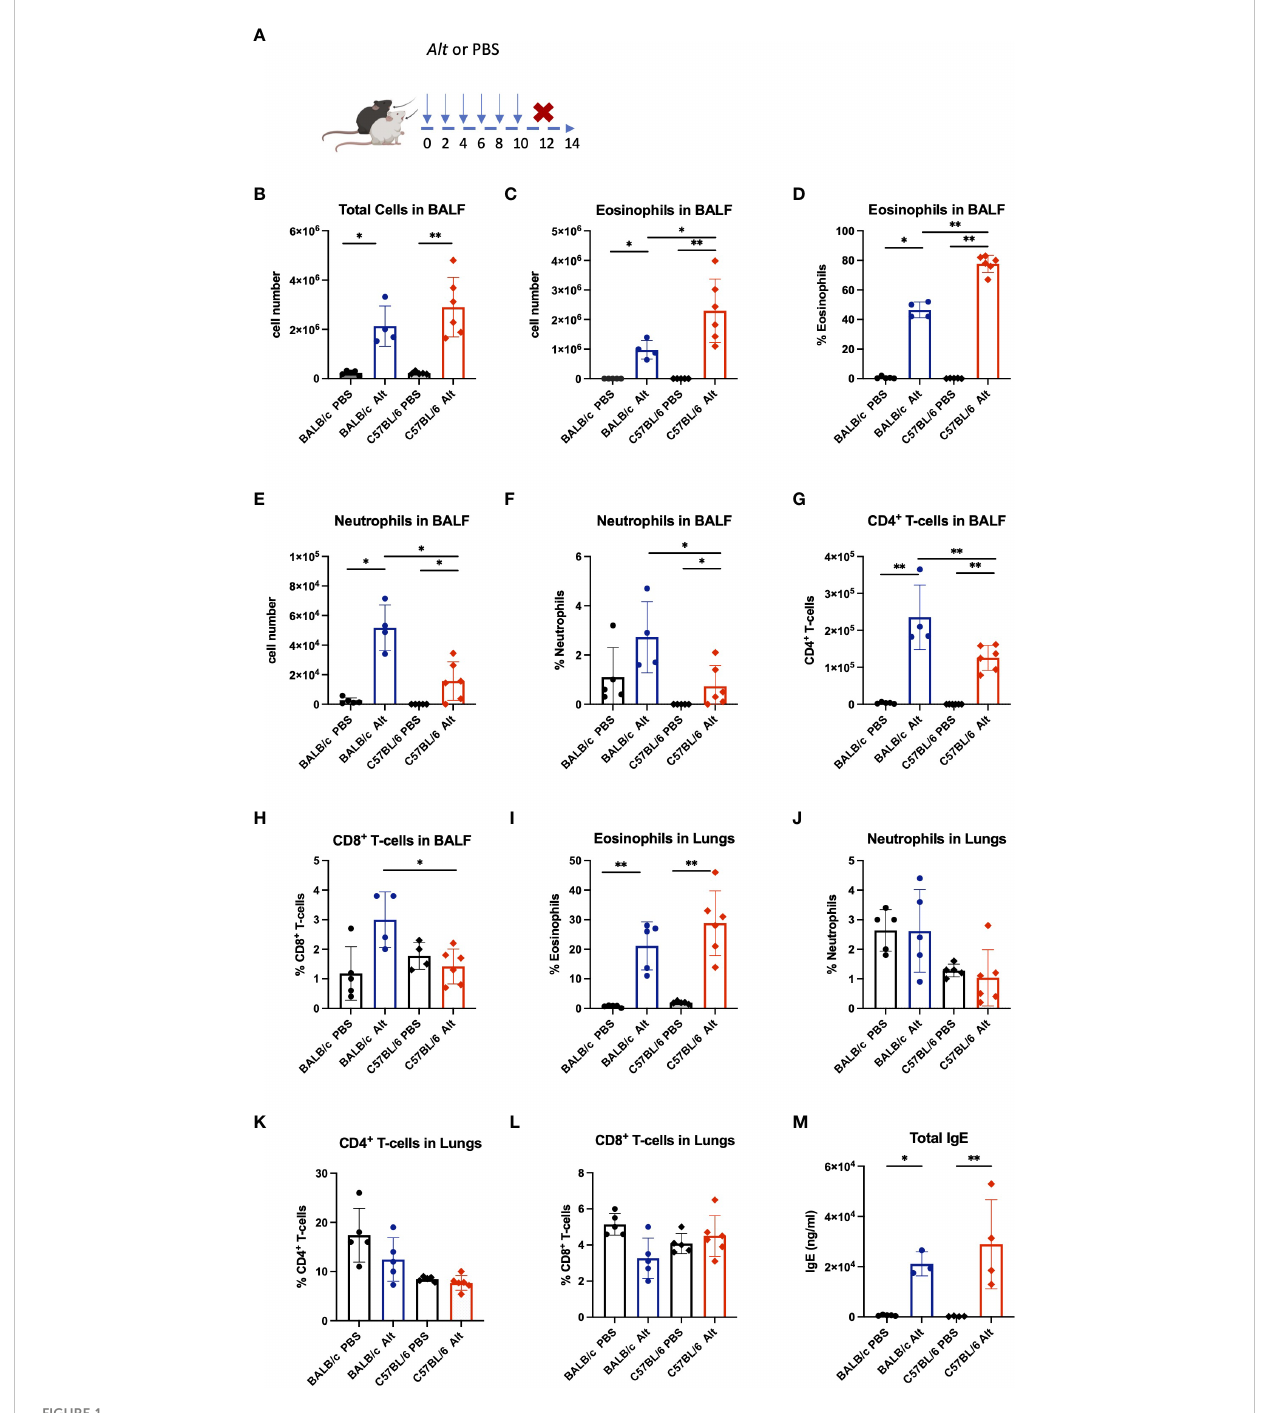
FIGURE 1 BALB/c and C57BL/6 mice were given six intratracheal applications of 20 µ g Alternaria alternata ( Alt) extract in PBS, controls received PBS alone. Forty-eight hours after the last application mice were sacri fi ced, and experimental samples were collected (A) . The absolute cell numbers in the bronchial lavage fl uid (BALF) are presented for total cell counts (B) , eosinophils (C) and neutrophils (E) in BALF. The percentage of eosinophils (D) and neutrophils (F) in BALF are presented. The BALF and lungs were analysed by fl ow cytometry and the in fi ltration of eosinophils (I) , neutrophils (J) , CD4 + T cells (G, K) and CD8 + T cells (H, L) in the BALF and lungs are presented as percentage. Mouse serum was collected 48h following the fi nal Alt application and the levels of total IgE in serum were determined using enzyme-linked immunosorbent assay (M) . The data are presented as scatter plots ± standard deviation (S.D.). Statistical signi fi cance between the groups was determined by one-way ANOVA with Dunn ’ s test for multiple comparisons. N=4-6 per group. *p < 0.05, **p <